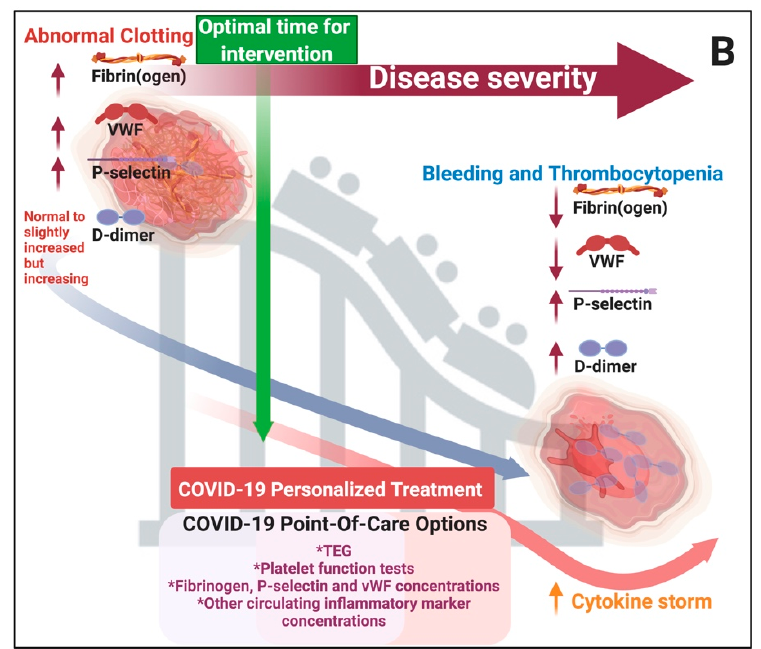
Figure 2. ( A ) Typical pathology in bleeding and clotting: the seesaw balancing act between bleeding and thrombocytopenia and hypercoagulation. This image was created with BioRender (https: // biorender.com / ). ( B ) Clinical manifestation of hypercoagulation, thrombocytopenia and bleeding during COVID-19 as well as clinical care options and optimal time for intervention: During the early stages of abnormal clotting, D-dimer levels are normal or slightly increased but will increase rapidly with progression of the disease (clinical observation). This image was created with BioRender (https: // biorender.com / ).